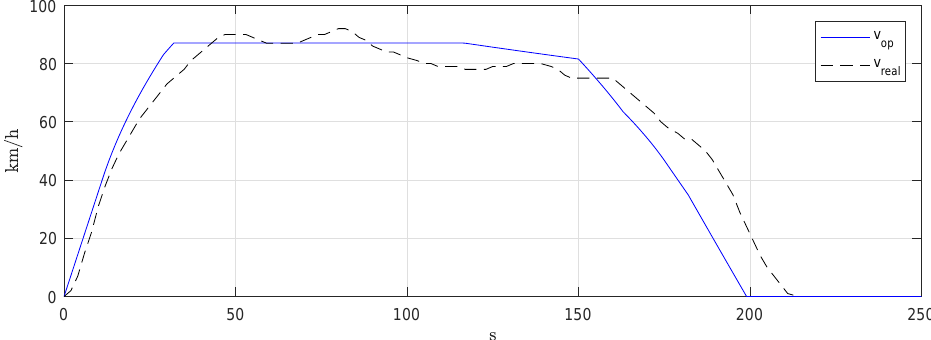
Figure 16. Case D—Actual (dashed black) and proposed (solid blue) speed